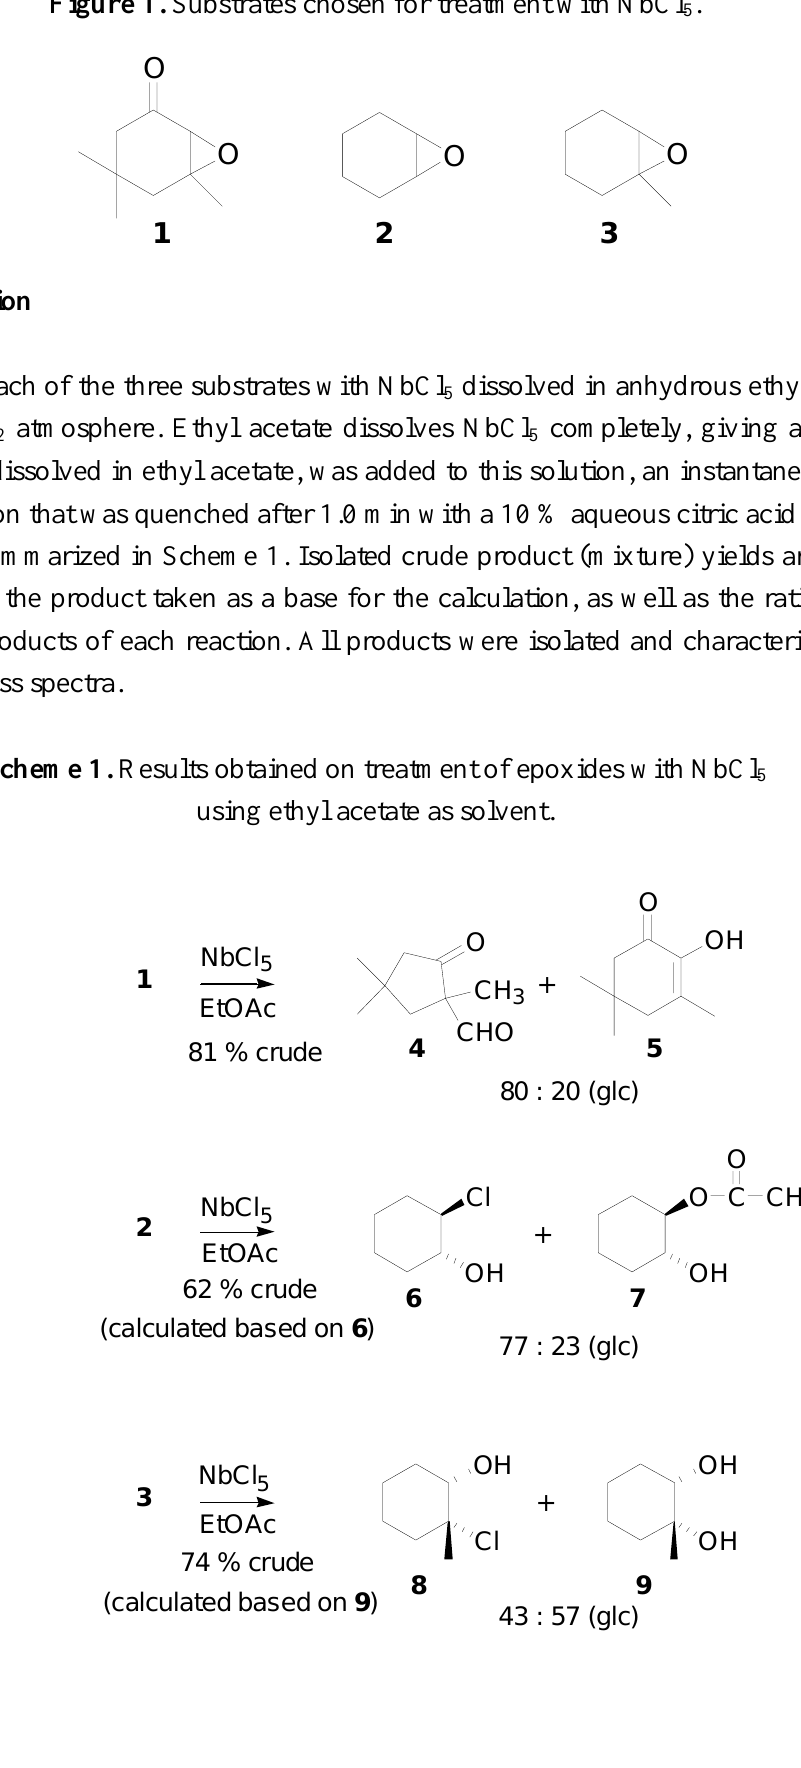
Figure 1. Substrates chosen for treatment with NbCl